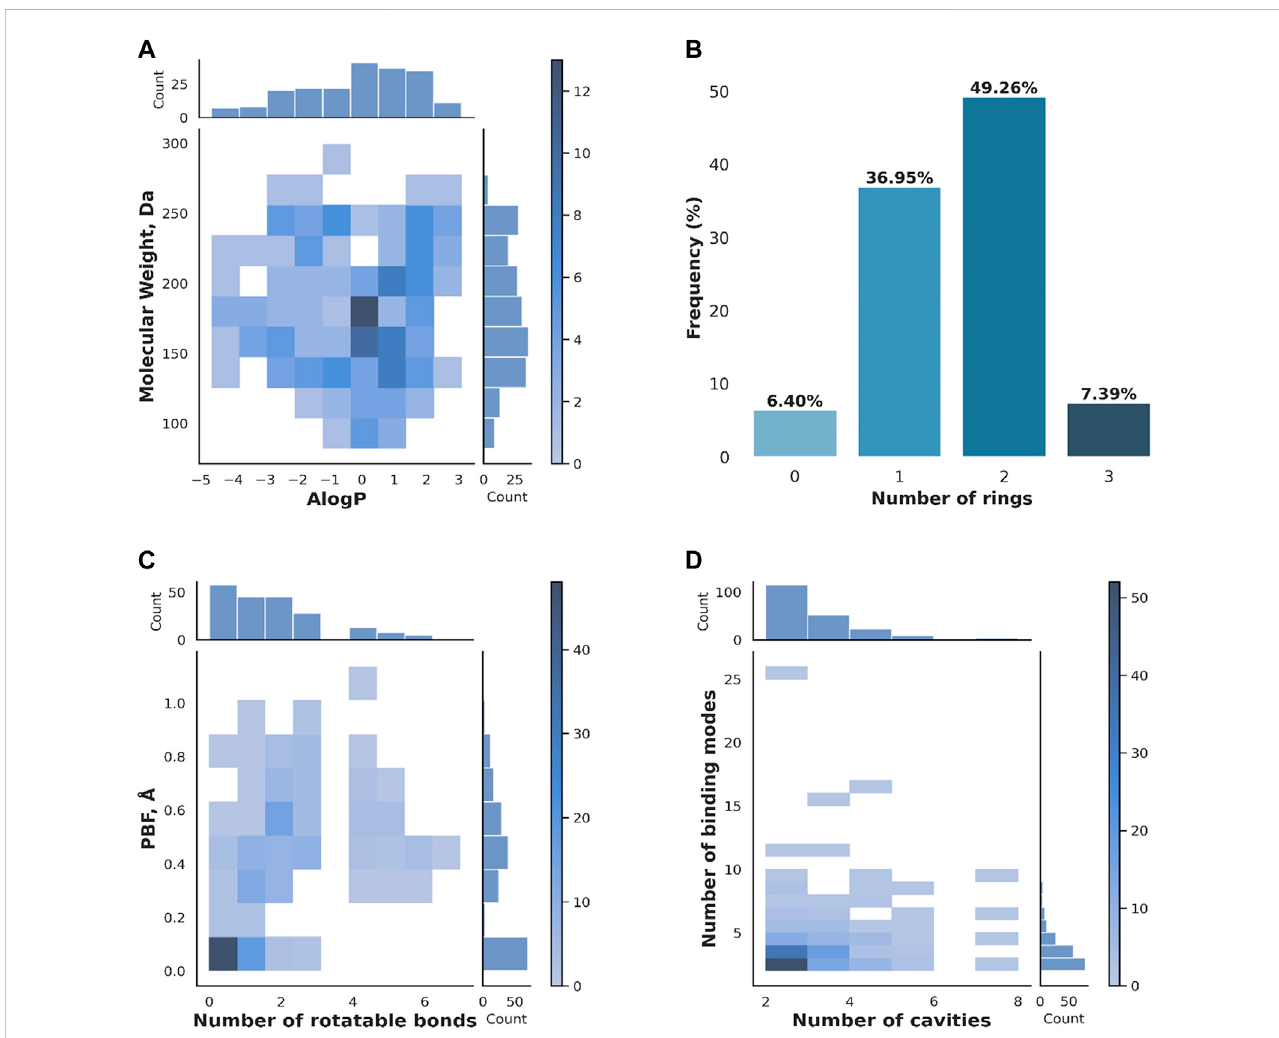
FIGURE 2 Properties of the versatile PDB fragments. (A) Molecular weight vs . AlogP (B) Number of rings (C) PBF vs . Number of rotatable bonds (D) Number of binding modes vs . Number of binding cavities. The distributions of individual properties are given on the top and side of the heat maps in (A) , (C) and (D) . The color scale on the side of the heat maps in (A) , (C) and (D) refers to the number of